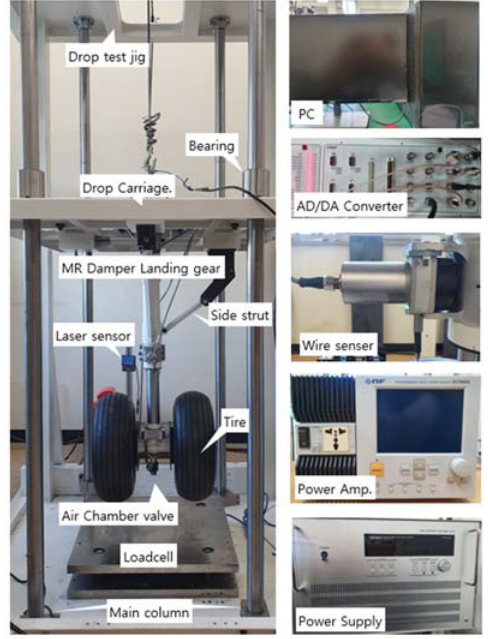
Figure 6. Experimental setup.